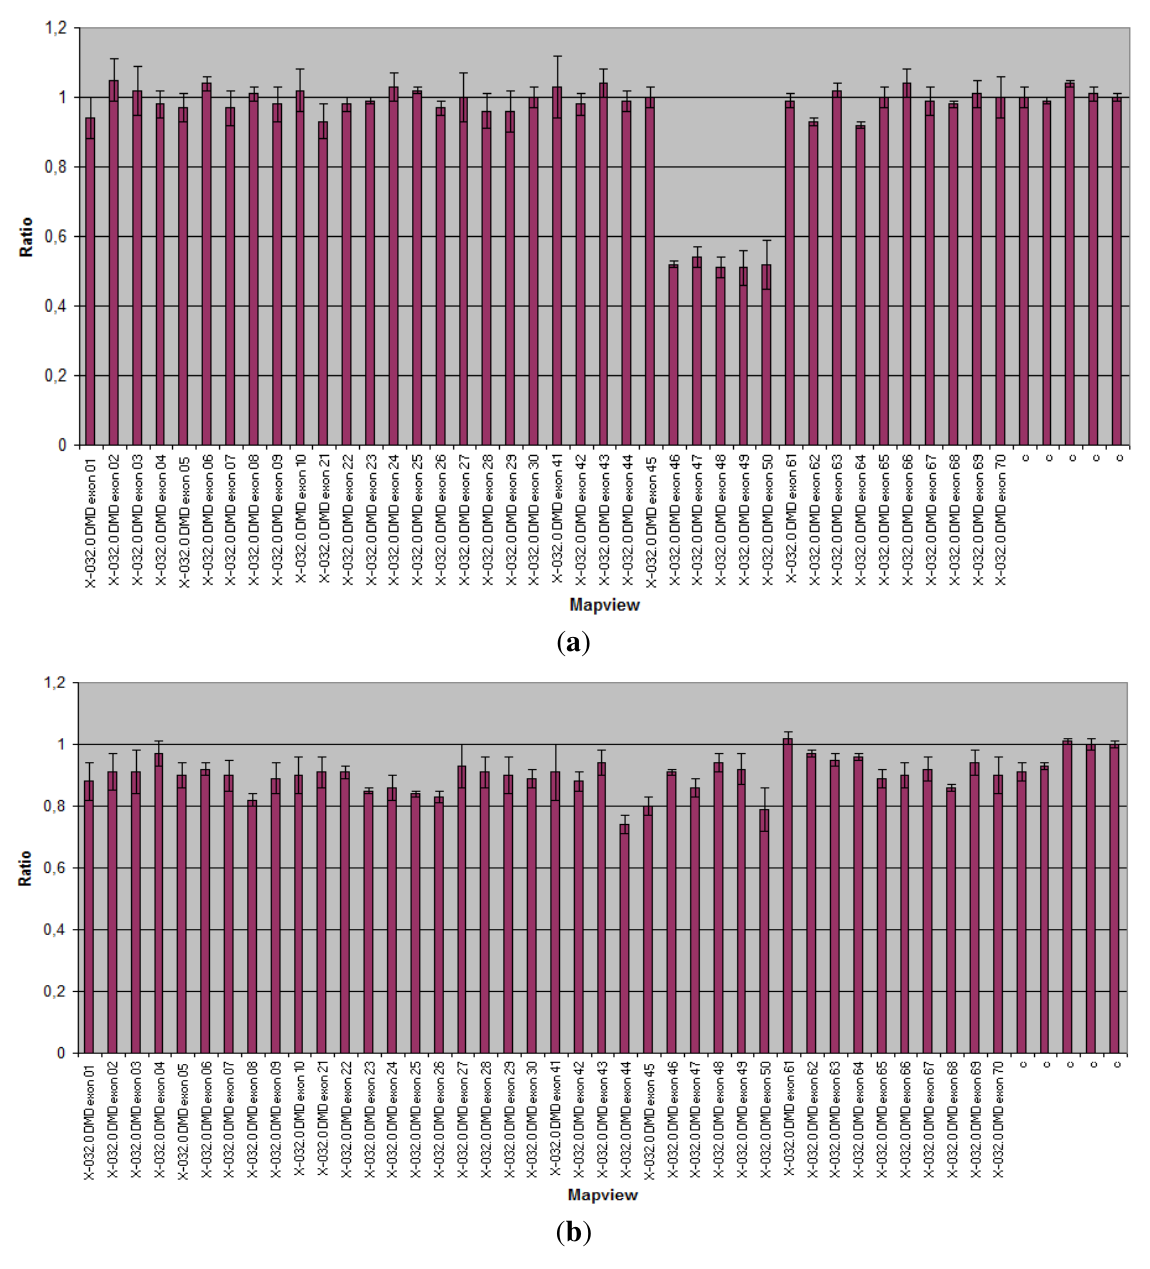
Figure 1. Multiplex Ligation-dependent Probe Amplification (MLPA) analysis of the Duchenne Muscular Dystrophy ( DMD ) gene. Abscissa represents DMD gene and control probes (c); ordinate represents fluorescent intensity of amplification. For each probe, the ratio <0.75 stands for deletion; and the ratio >1.3 stands for duplication. ( a ) MLPA analysis showing a heterozygous deletion of exons 46–50 (ratio < 0.75) of the DMD gene in the mother of an affected patient; ( b ) Normal control (075 < ratio <